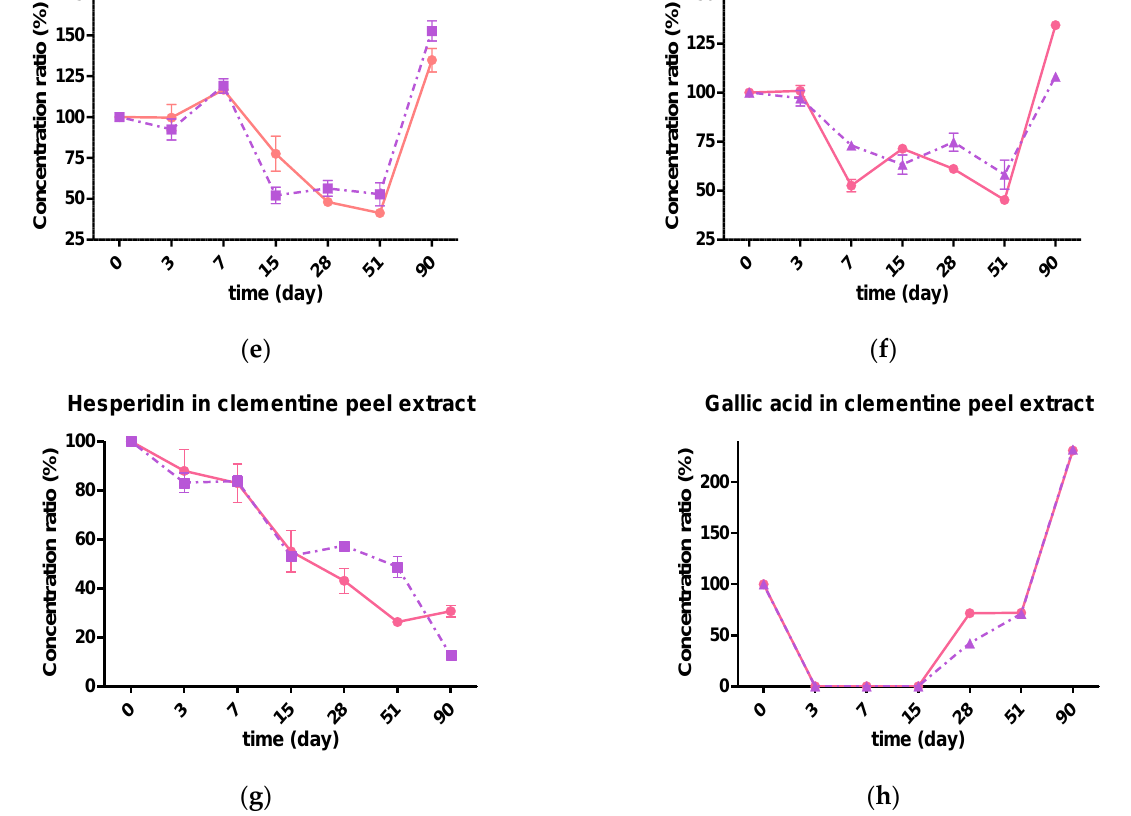
Figure 6. Stability of the individual polyphenols monitored in lemon peel extract ( a – d ) and clementine peel extract ( e – h ) during storage at 20 °C and − 20 °C.